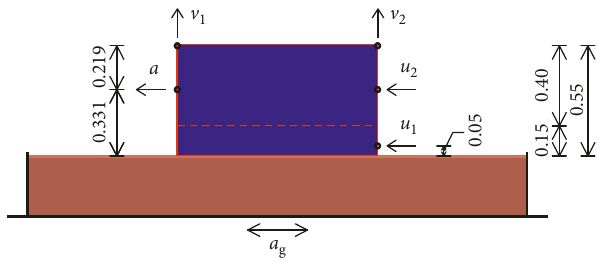
Figure 8: Measured quantities.